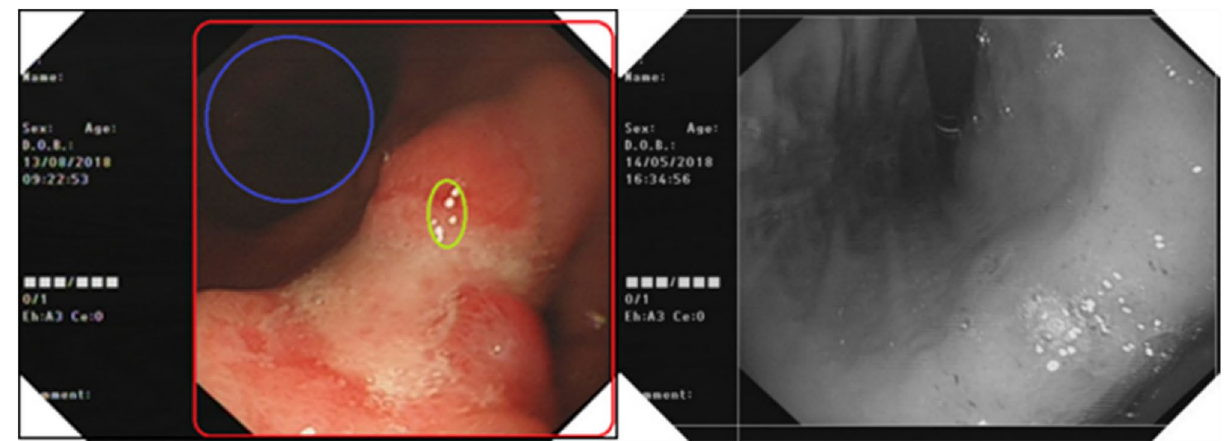
Figure 1. The original picture area division (left) and the area of interest boundary detection effect